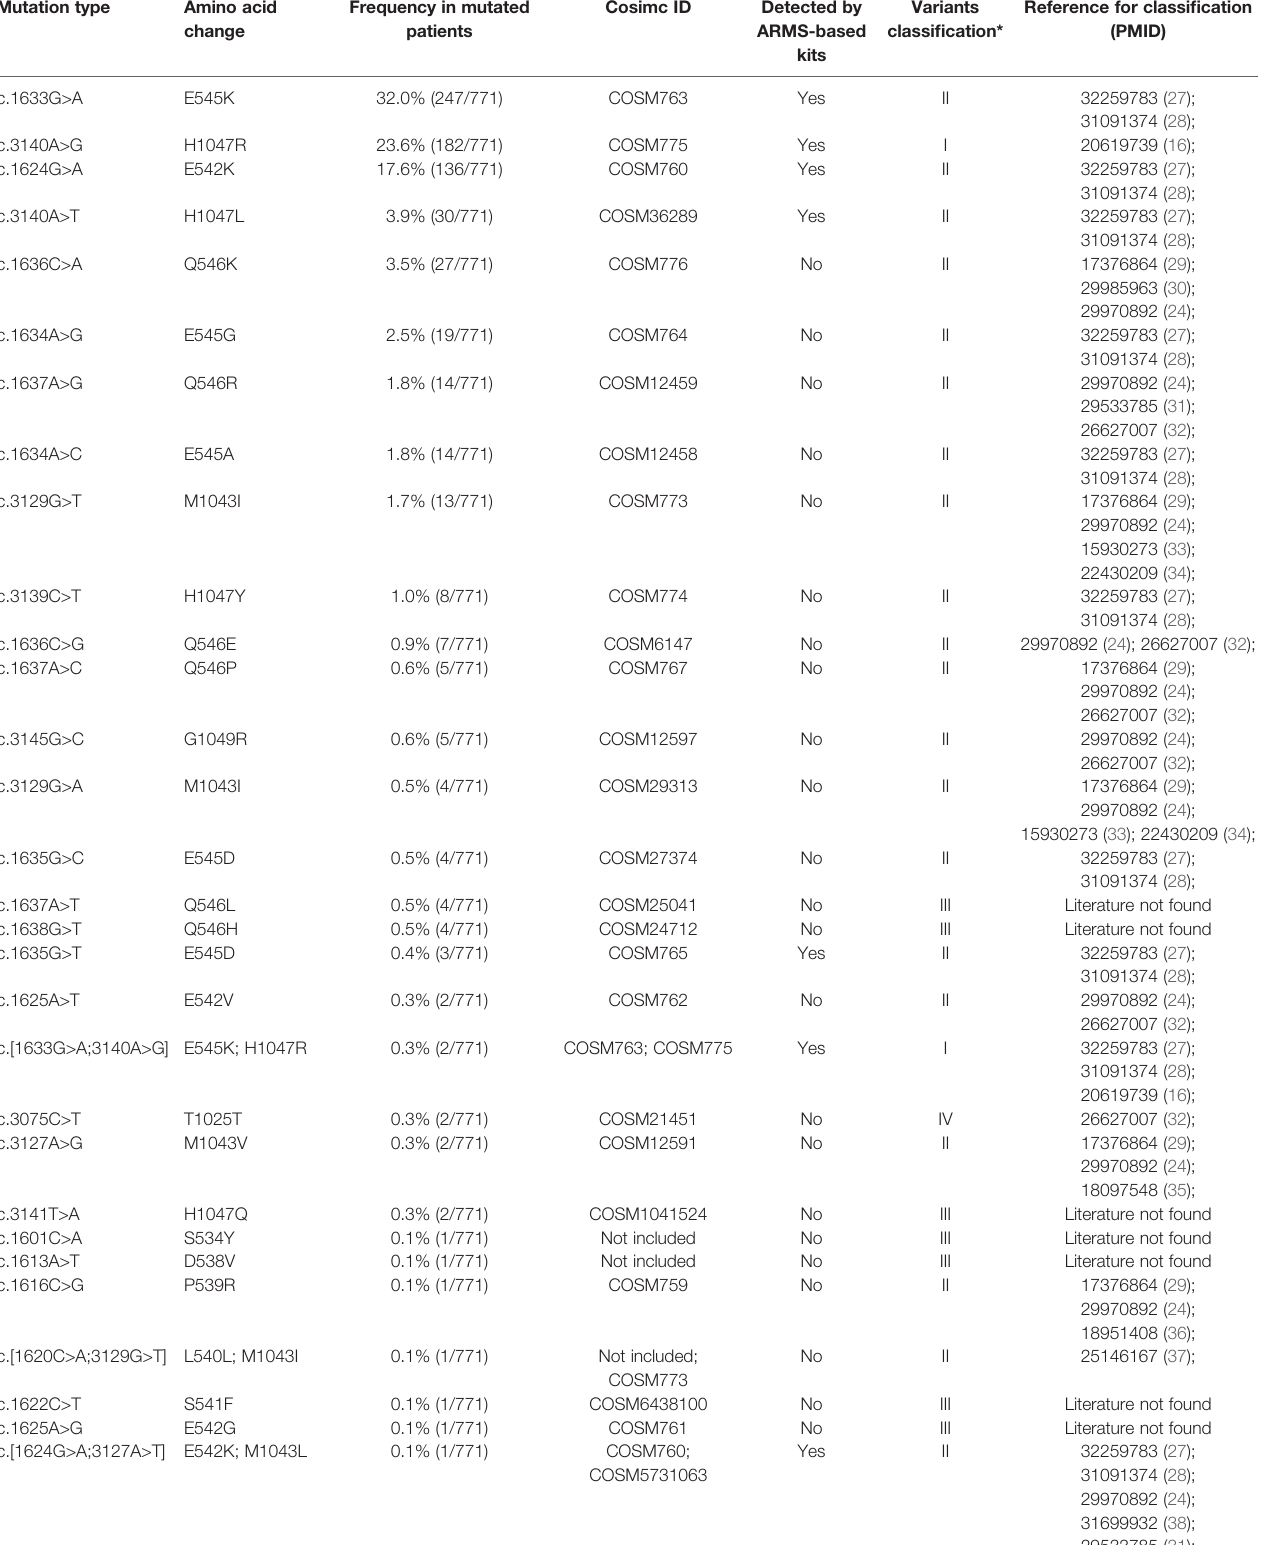
TABLE 2 | Mutation types and classi fi cation in PIK3CA exon 9 and 20 of Chinese CRC